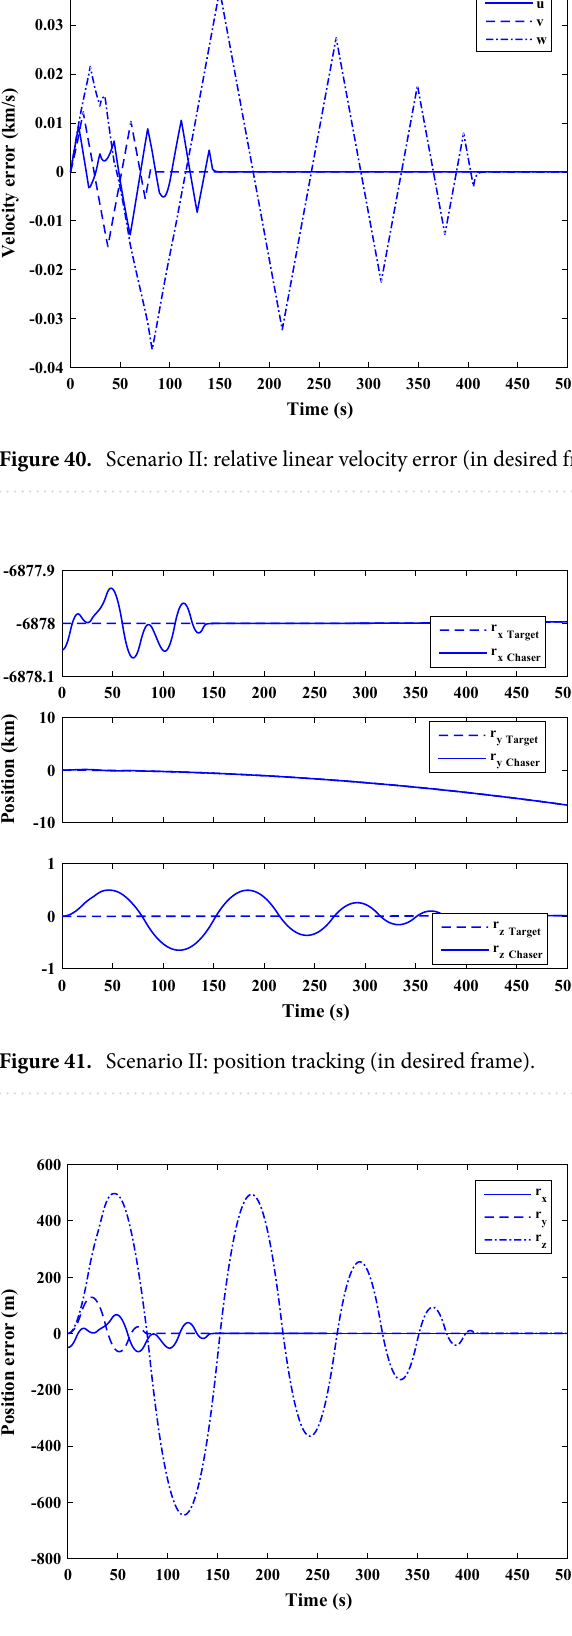
Figure 42. Scenario II: relative position error (in desired frame).